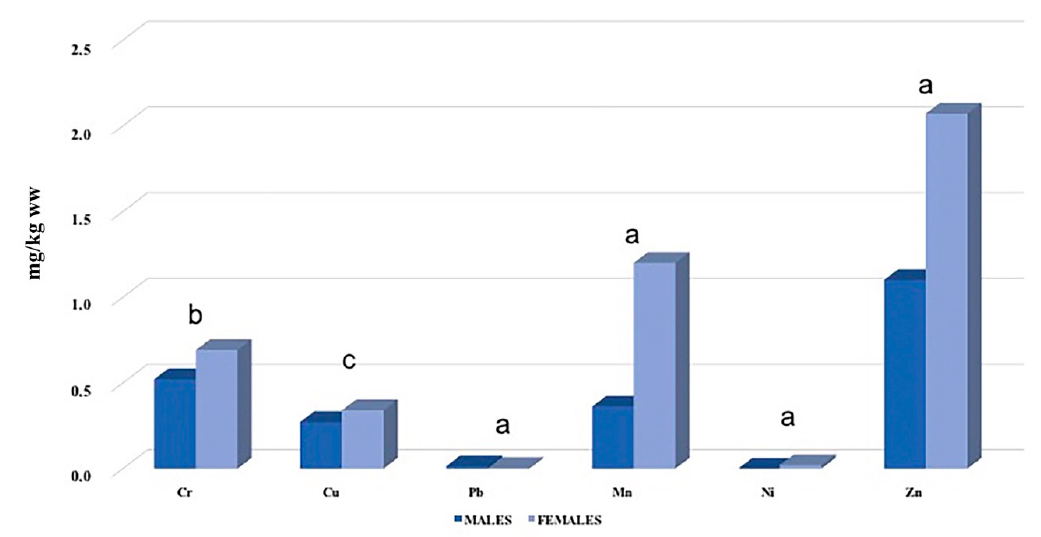
Figure 3. Mean values of metals and metalloids concentrations in muscle (mg / kg ww). Significant differences between sex: a, p < 0.001; b, p < 0.01, c: p < 0.05. J. Mar. Sci. Eng. 2020 , 8 , x FOR PEER REVIEW